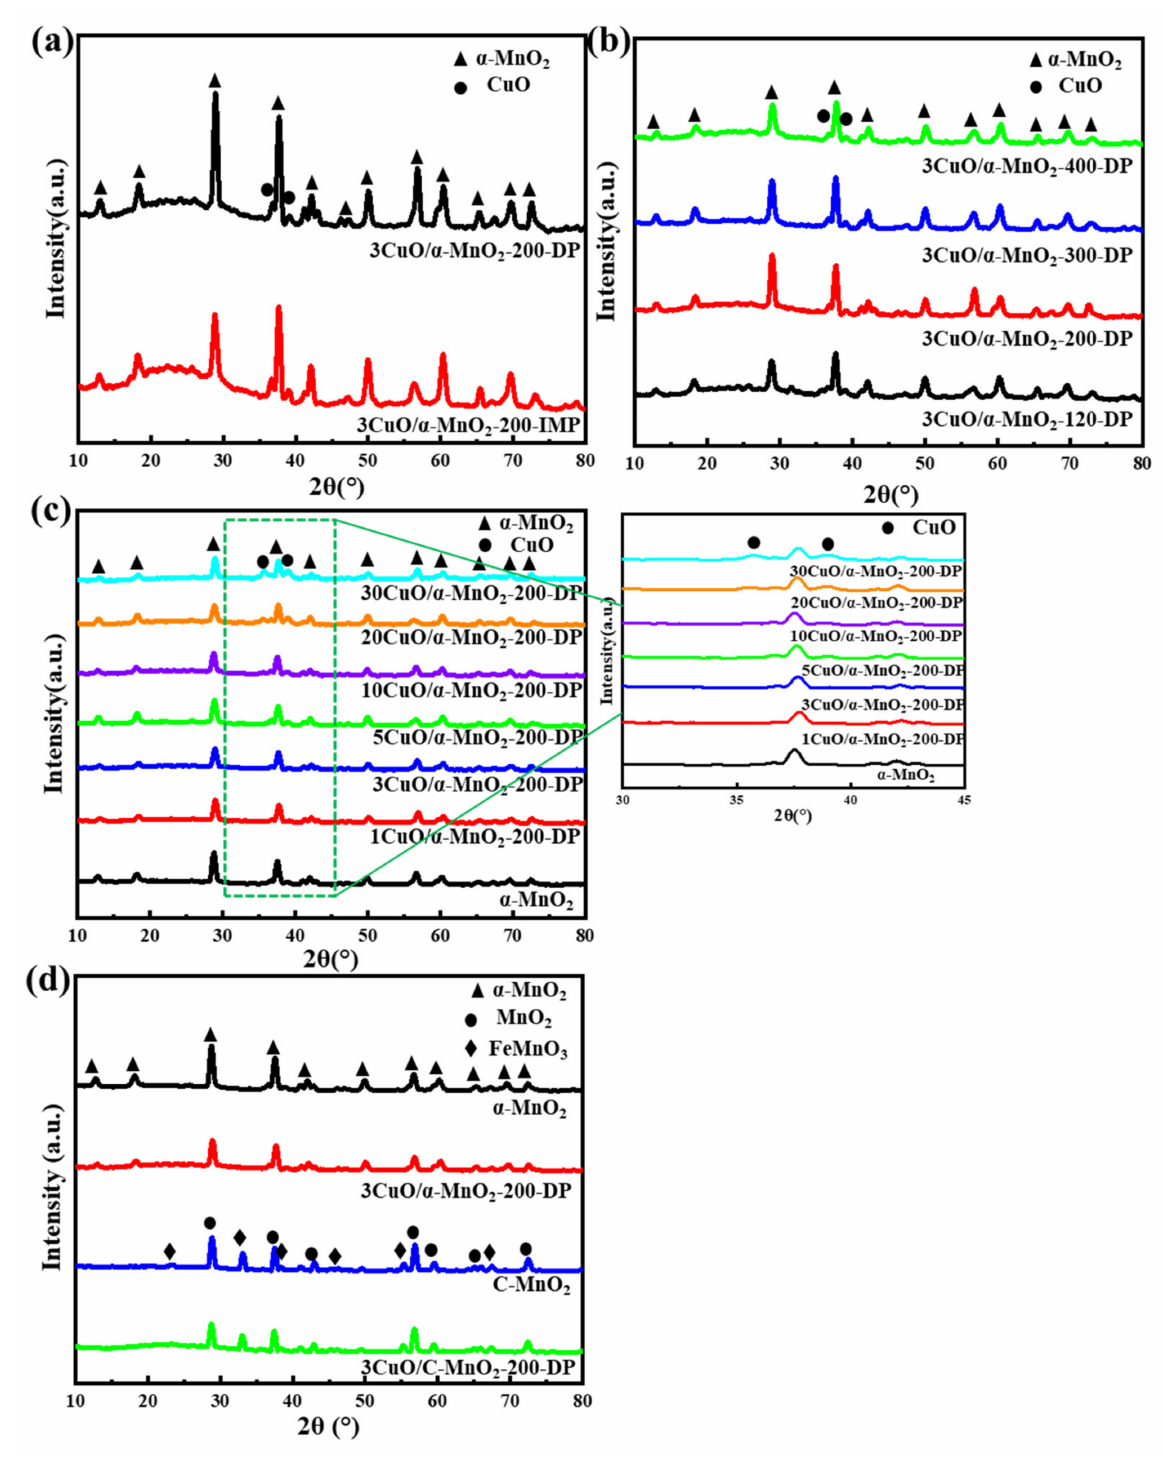
Figure 1. XRD patterns of ( a ) 3CuO/ α -MnO 2 -200-DP and 3CuO/ α -MnO 2 -200-IMP catalysts under different loading methods; ( b ) 3CuO/ α -MnO 2 - T -DP ( T = 120, 200, 300, 400) catalysts with different calcination temperatures; ( c ) x CuO/ α -MnO 2 -200-DP ( x = 0, 1, 3, 5, 10, 20, 30) catalysts with different CuO loading; ( d ) α -MnO 2 nanowire, commercial MnO 2 (C-MnO 2 ) and corresponding